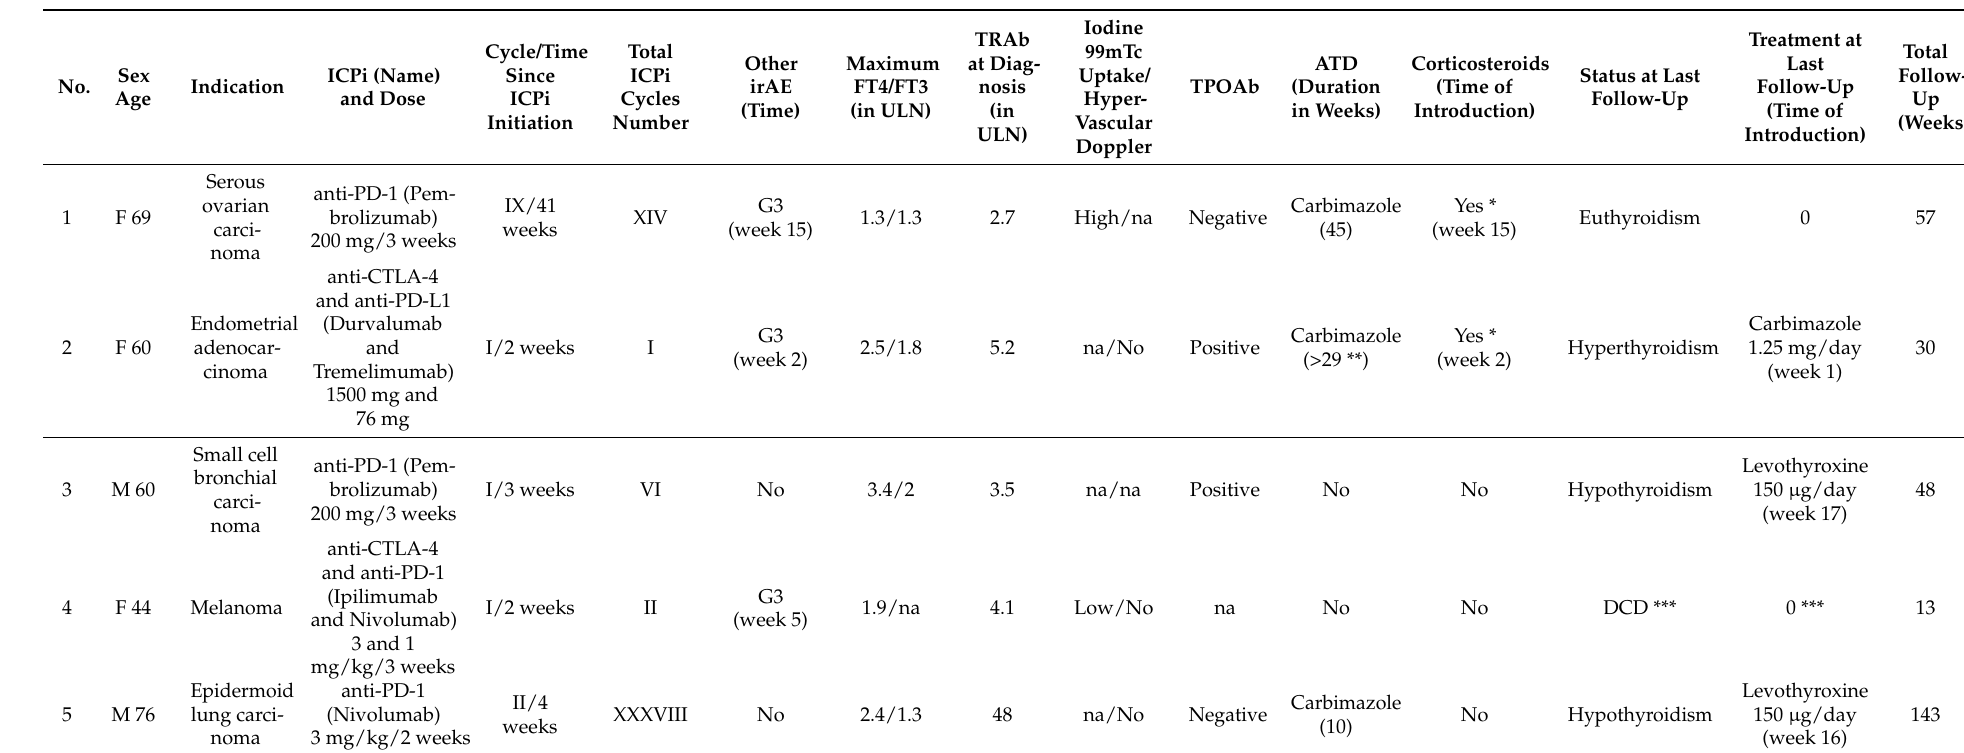
Table 1. ICPi-induced Graves’